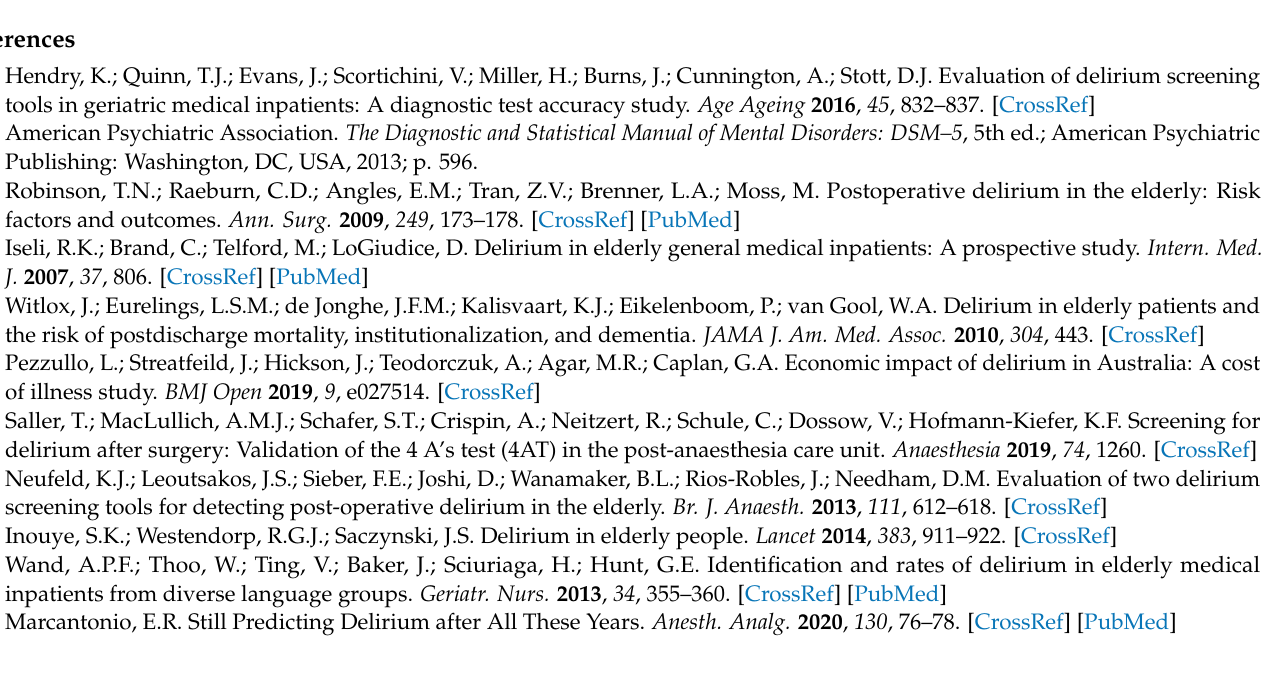
diagnostic test accuracy studies. Table S2: 3D-CAM Instrument. Table S3: DSM-5 criteria for delirium